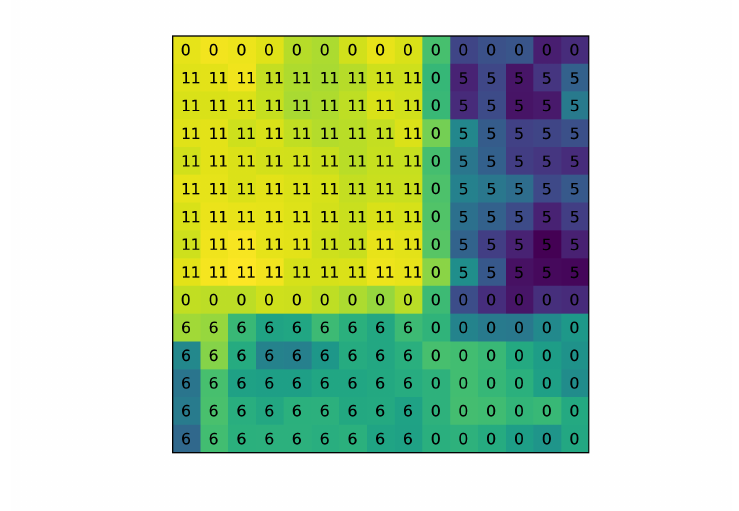
Figure 14. The first-layer SpatialSE simulation value for an 11 × 11 spatial